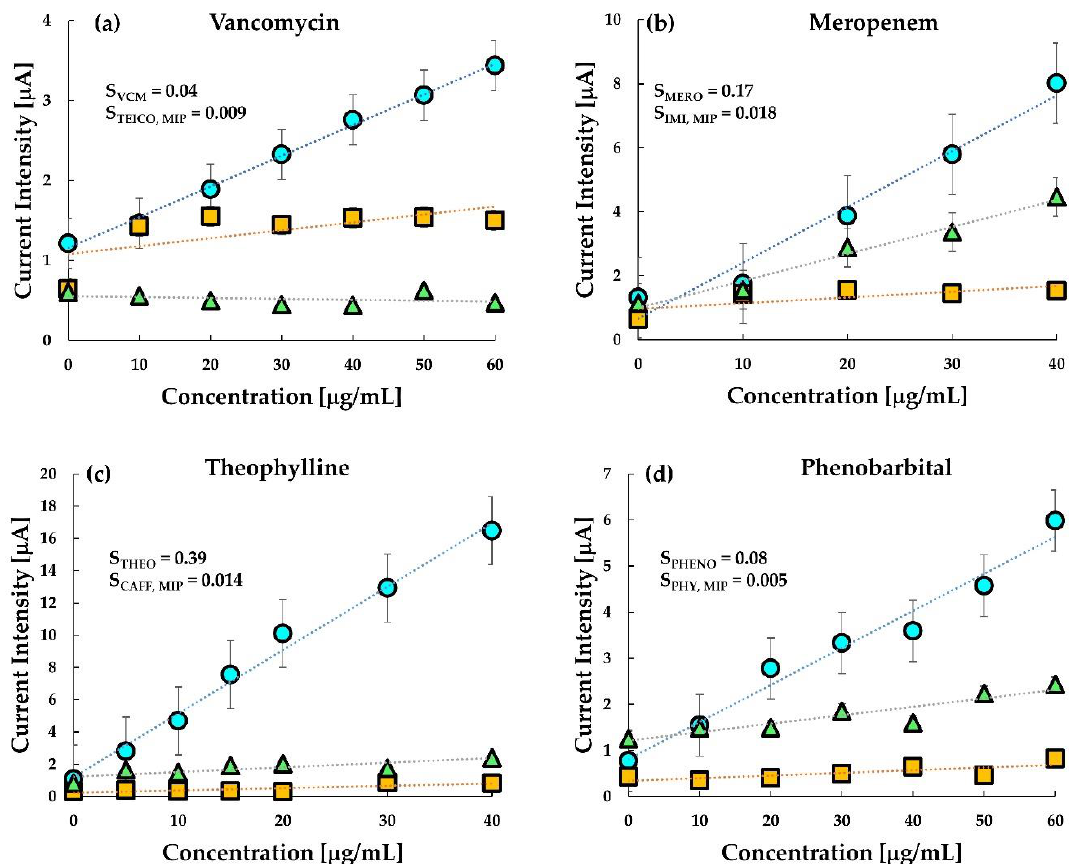
Figure 6. Selectivity test in saline of the target by MIP (circles), the analogue by MIP (squares) and analogue by untreated carbon paste (triangles): ( a ) vancomycin, ( b ) meropenem, ( c ) theophylline and ( d ) phenobarbital.